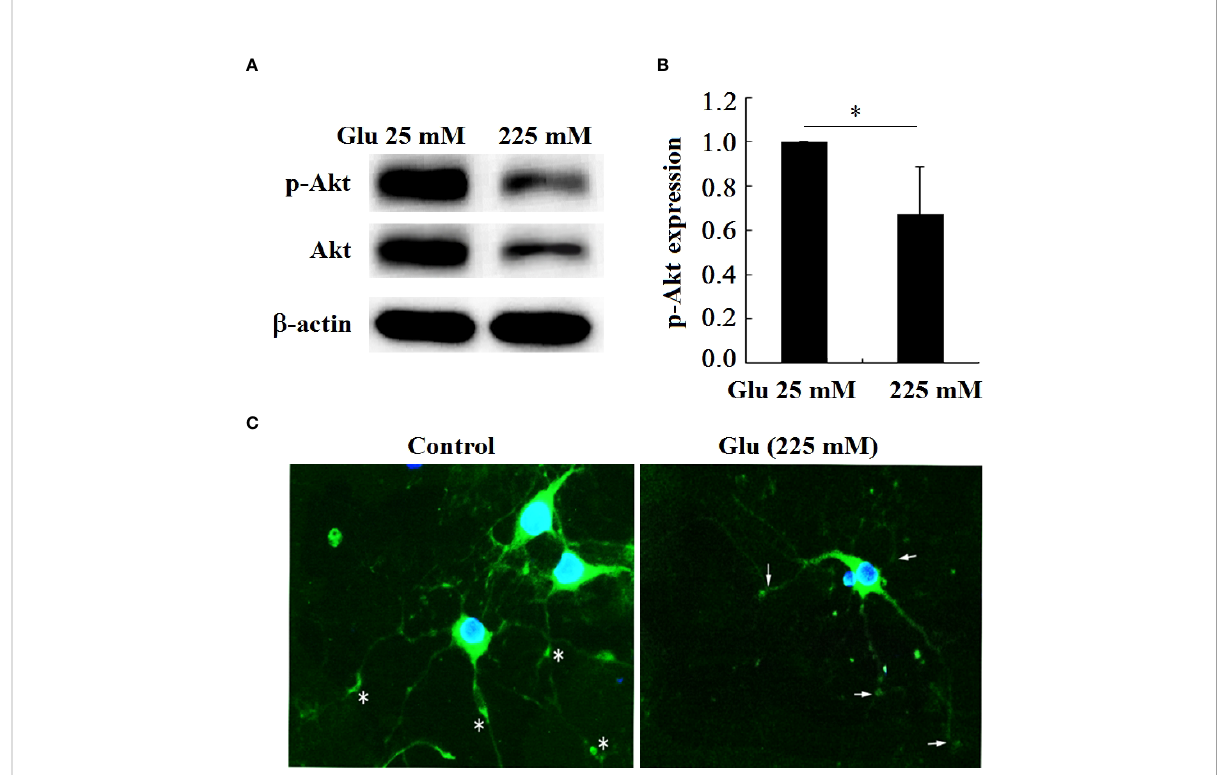
FIGURE 9 P-Akt and Akt expression in hippocampal neurons decreased under high glucose stimulation, * P < 0.05. (A) Western blot to detect the expression of Akt phosphorylation. (B) Grayscale analysis of Akt phosphorylation. (C) Immuno fl uorescence analysis of the expression of p-Akt under high glucose stimulation (×400). The arrow refers to the expression of p-Akt in the growth cone and synaptic